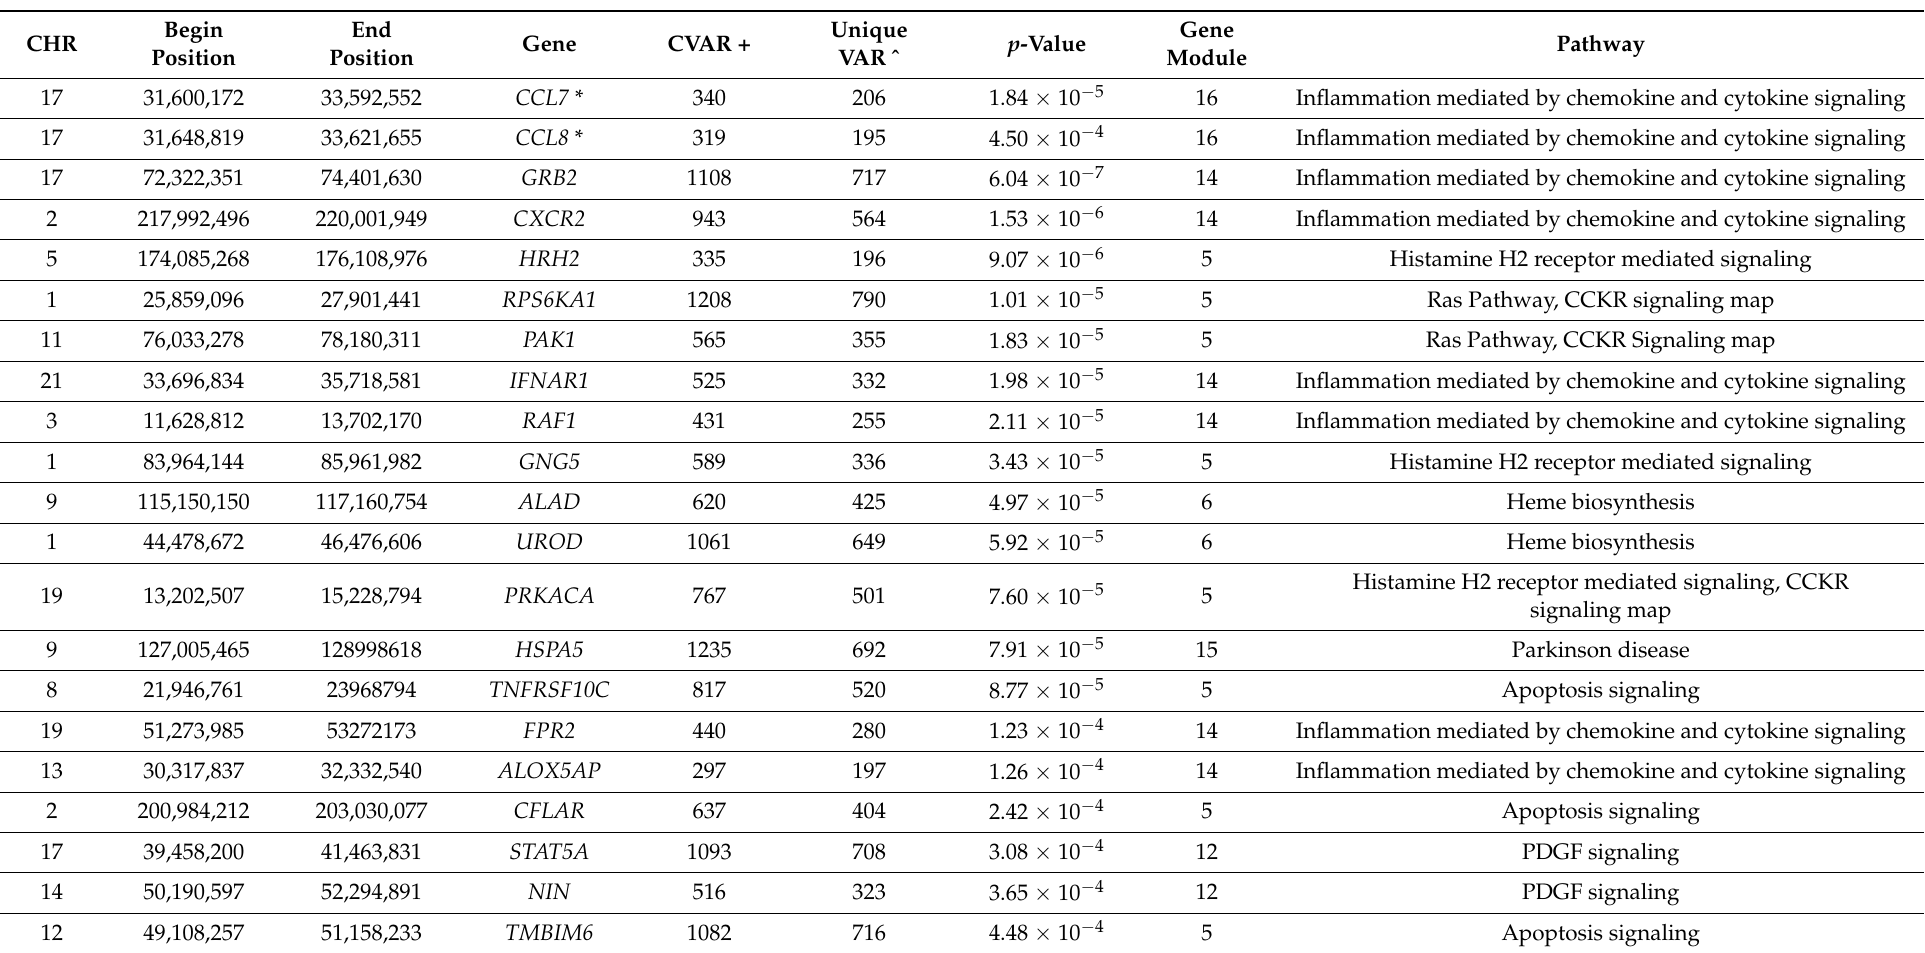
Table 4. Significant pathway-level eQTLs in the brain or blood by aggregating cis rare